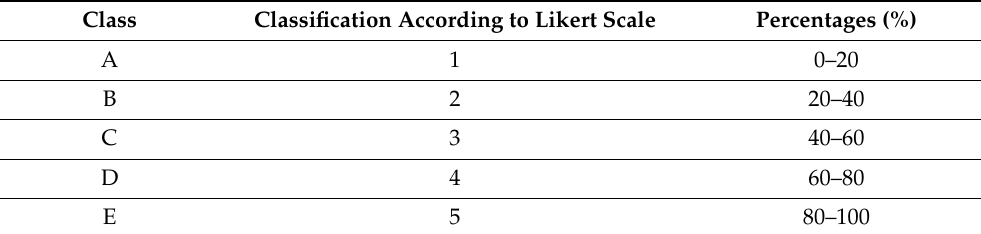
Table 1. Definitions of classes of percentages according to the Likert Scale. Class Classification According to Likert Scale Percentages